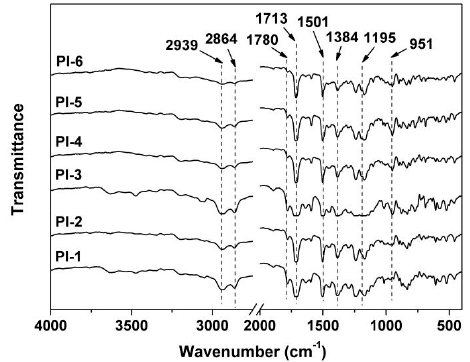
Figure 2. FT-IR spectra of PI films.